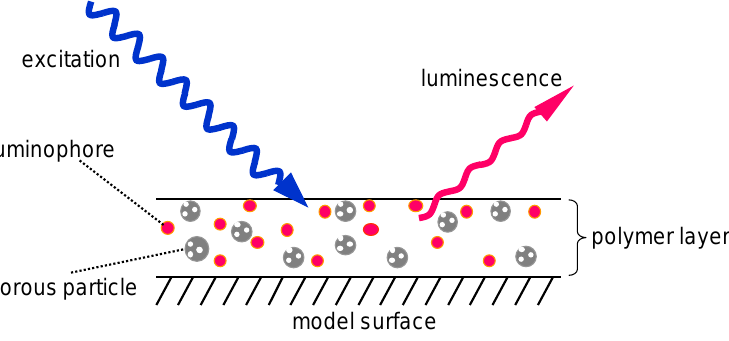
Figure 1. Schematic description of a polymer-ceramic PSP